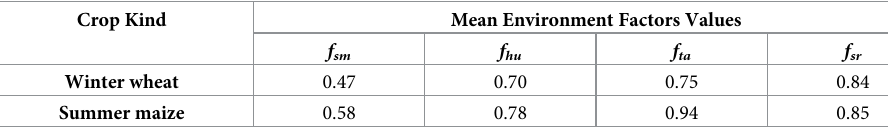
Table 4. Mean environmental factor values for summer maize and winter